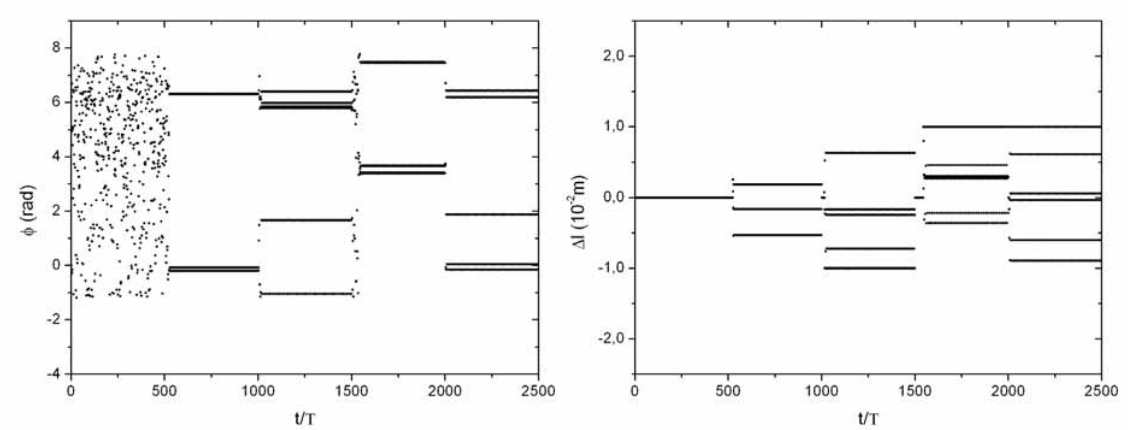
Fig. 9. Response under control. (a) Temporal alternating of UPOs in Poincar´e section #1. (b) Control